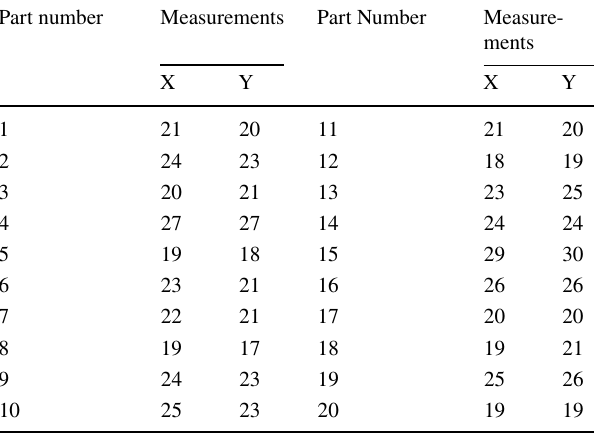
Table 12 Data for gauge capability assessment application Part